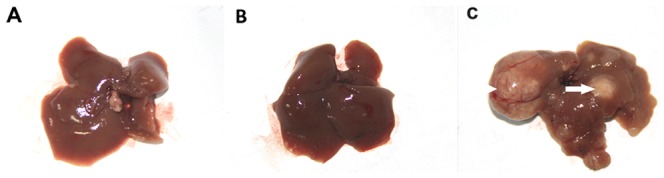
Representative images of the mice liver specimen at 35-week.A: Control group; B:Maotai+ DEN group; C: Ethanol+ DEN group. No obvious macroscopic hepatic pathological changes was seen in control group and Maotai+ DEN group. The liver in ethanol+ DEN treated group almost showed swelling, cirrhosis, brown and produced unequal sized gray nodules(arrows indicate the tumor node).